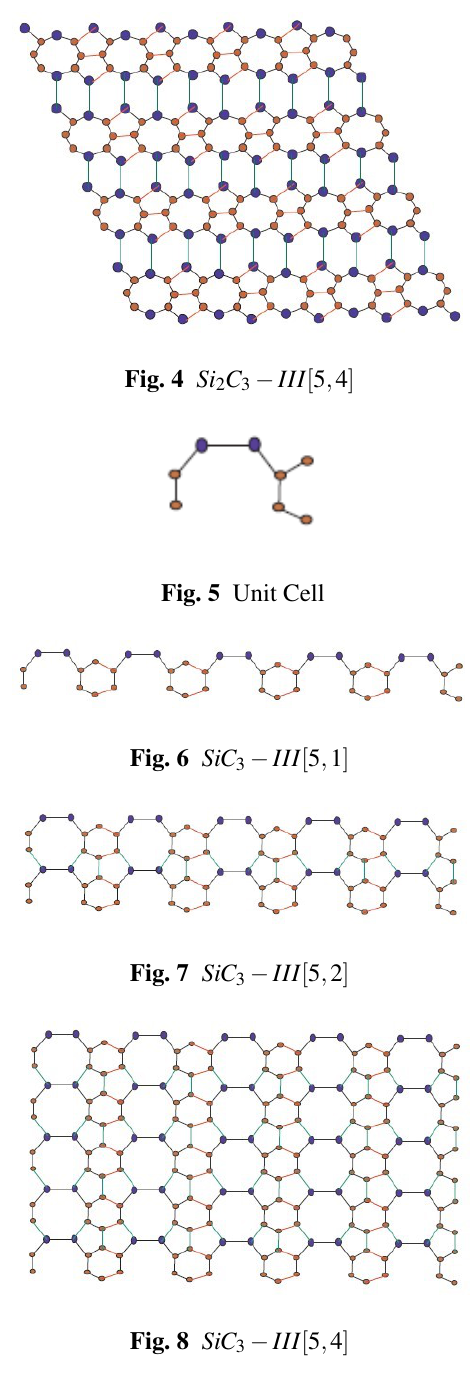
Fig. 8 SiC 3 − III [ 5 , 4